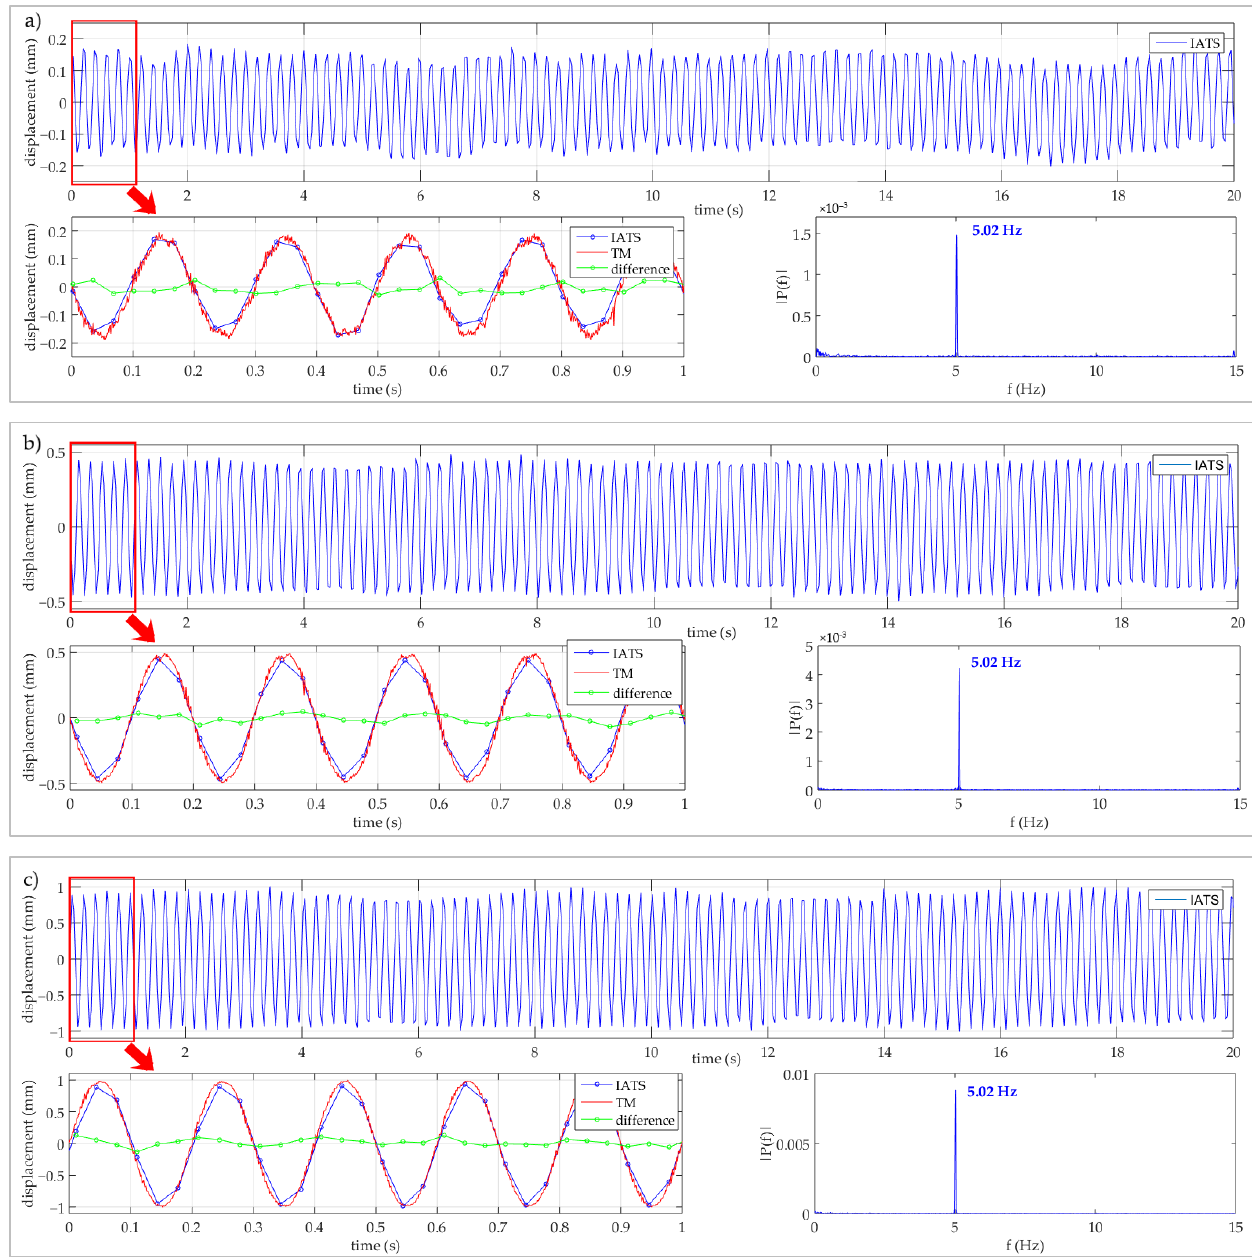
Figure 5. The measurements obtained by means of IATS prototype of simulated dynamic vertical displacements by TM, comparison of simulated and measured displacements with the difference between them and determined frequencies. In every test, the simulated predefined frequency was F = 5.0 Hz with different amplitudes of A = 0.2 mm ( a ), A = 0.5 mm ( b ), and A = 1.0 mm ( c ).